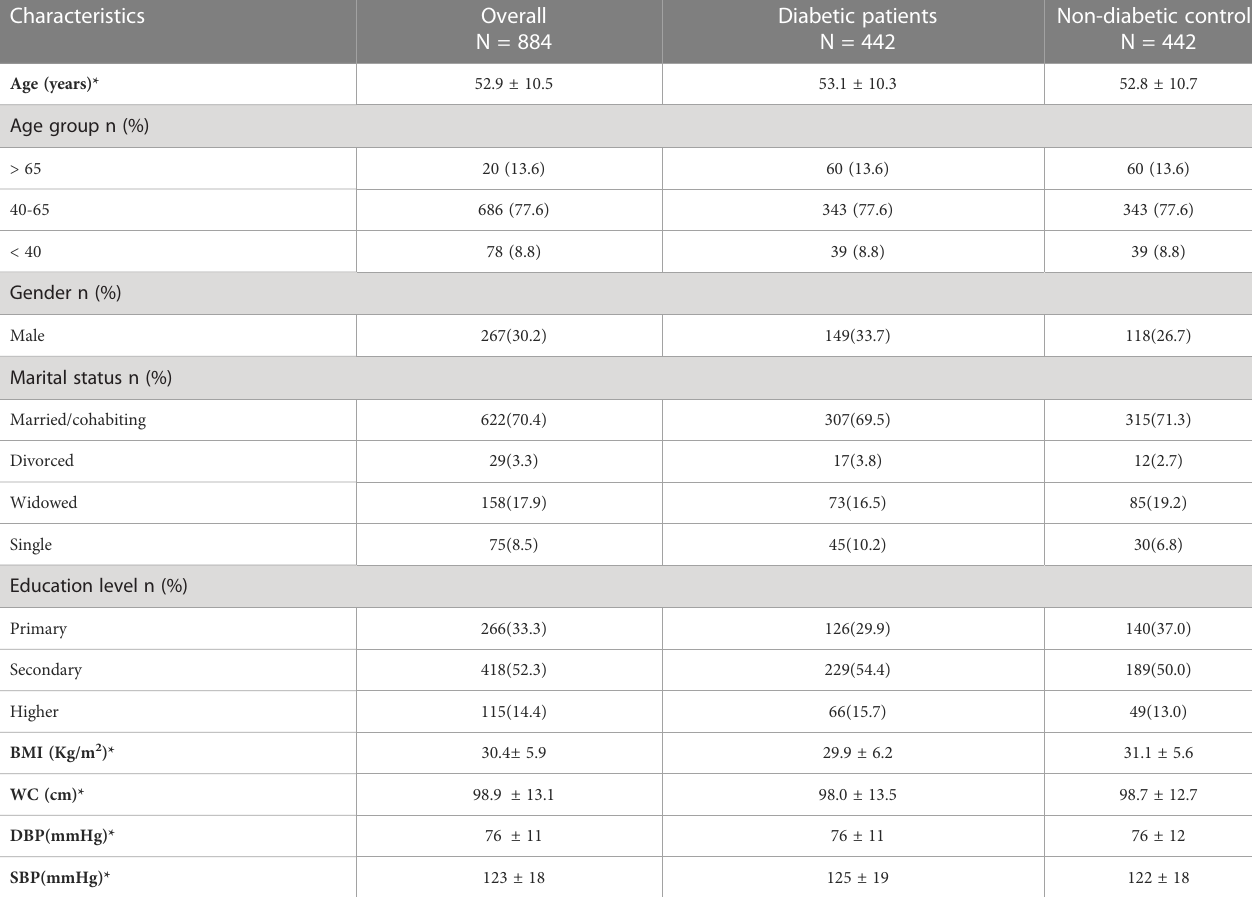
TABLE 1 General Sociodemographic and clinical characteristics of diabetic and non-diabetic patients.